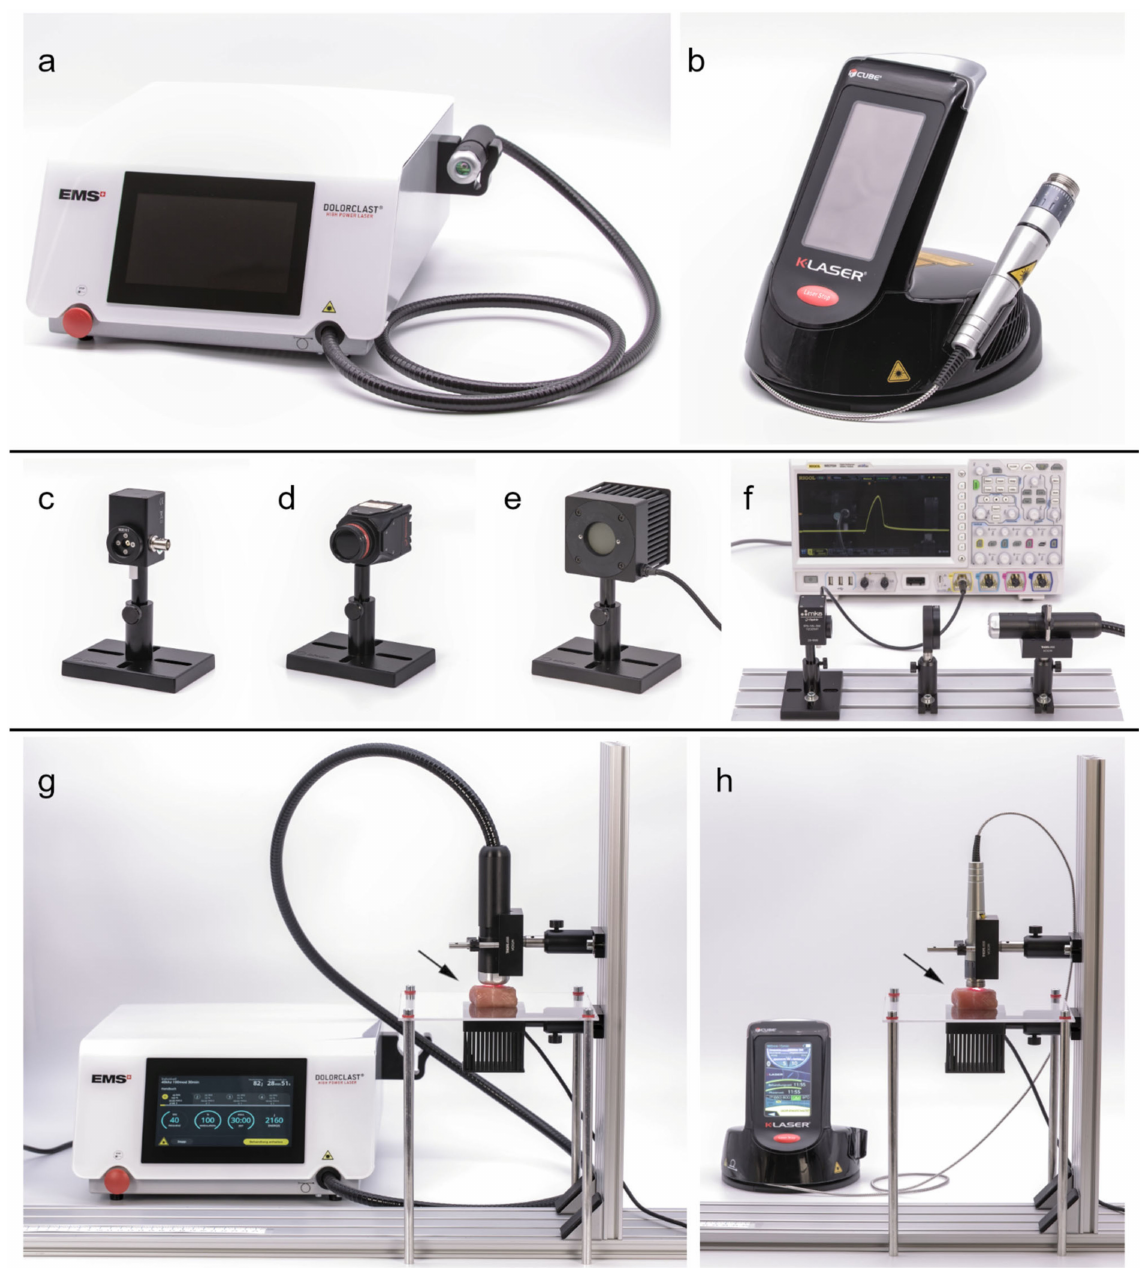
Figure 1. Laser therapy devices, sensors and experimental setups used in the present study: ( a ) EMS laser (Dolorclast High Power Laser; Electro Medical Systems, Nyon, Switzerland); ( b ) K-laser (Cube 4; Eltech K-Laser; Treviso, Italy); ( c ) Fast Photodiode (FPD-VIS-300; Ophir Spiricon Europe, Darmstadt, Germany) for temporal beam characterizations; ( d ) experimental setup for laser pulse characterization measurements with the handpiece of the EMS laser (right), the FPD (left) and an optical diffusor in the beam line (center); the FPD is connected to an oscilloscope (MSO7024; Rigol Technologies, Suzhou, China); ( e ) beam profiling camera (LT665; Ophir Spiricon Europe) that can measure spa- tial power density maps; ( f ) thermal power sensor (50(150)A-BB-26-PPS; Ophir Spiricon Europe); ( g ) experimental setup for penetration depth measurements with the EMS laser; ( h ) experimental setup for penetration depth measurements with the K-laser. The arrows in ( g , h ) point to a tissue specimen (15 mm thick chicken muscle tissue) on the specimen